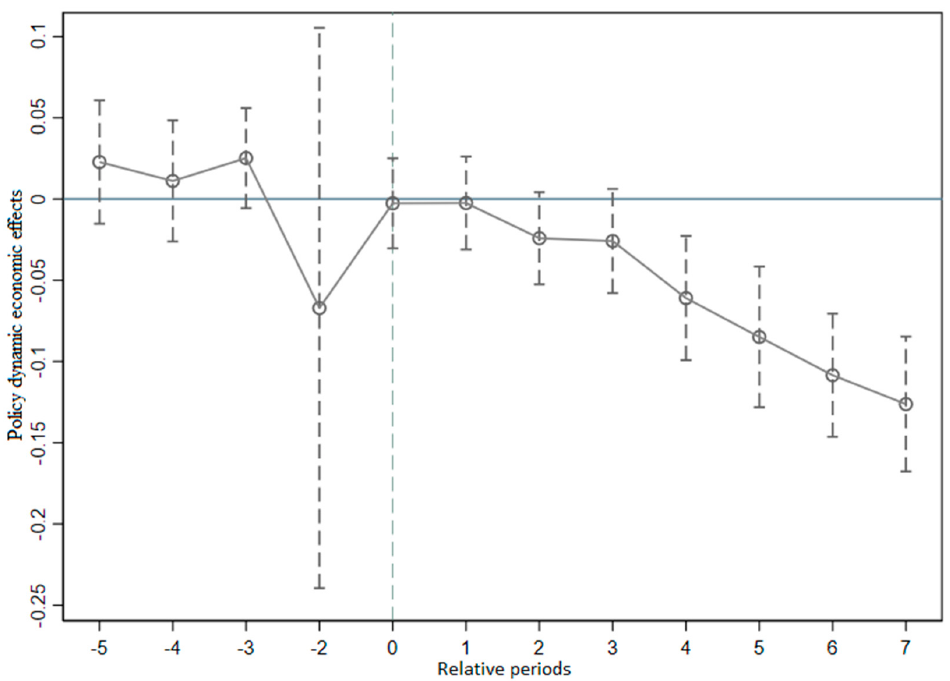
Figure 3. Results of parallel trend test.